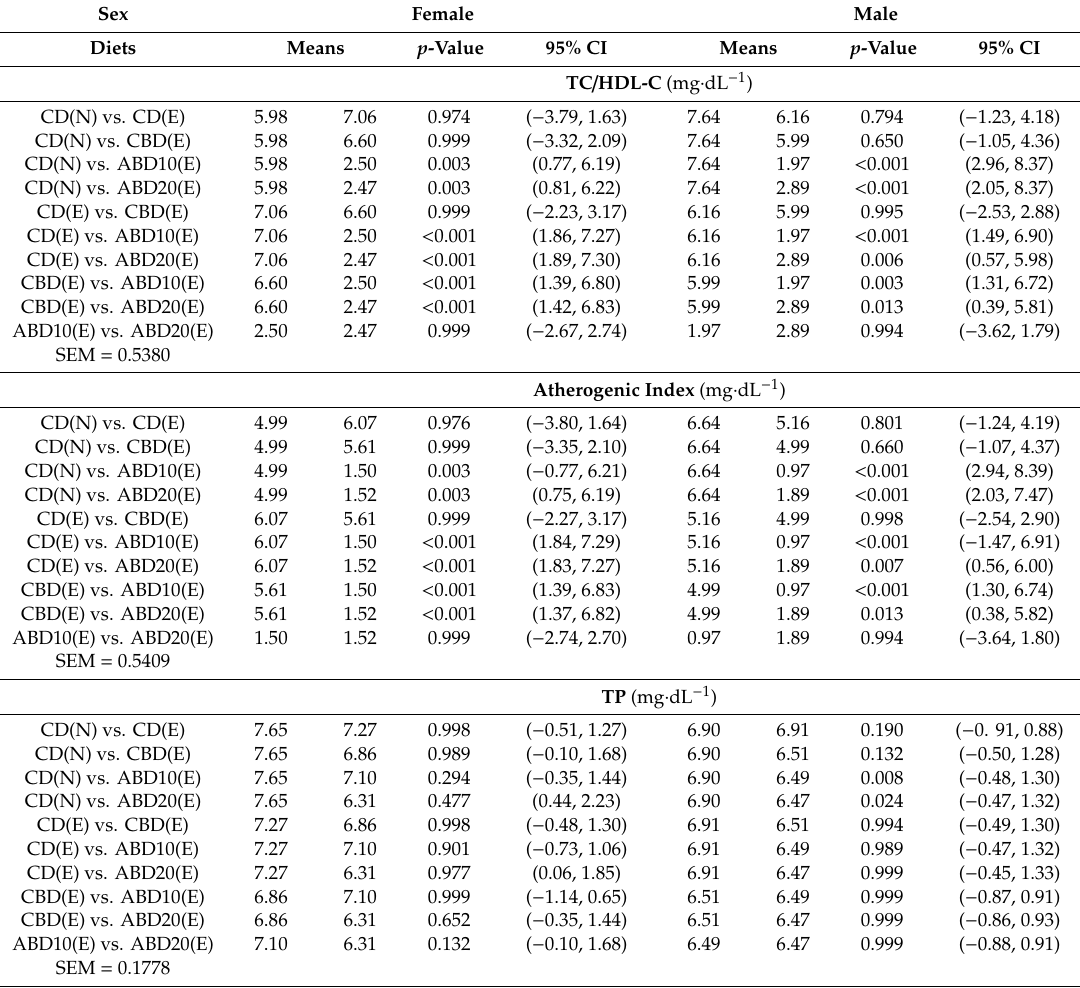
Table 6. E ff ect of 8-week consumption of diets prepared with bread of amaranth on serum cardiac risk factor (TC / HDL-C), atherogenic index ((TC – HDL-C) / HDL-C) and total protein (TP) in rats (weeks 23 to 31 of age).